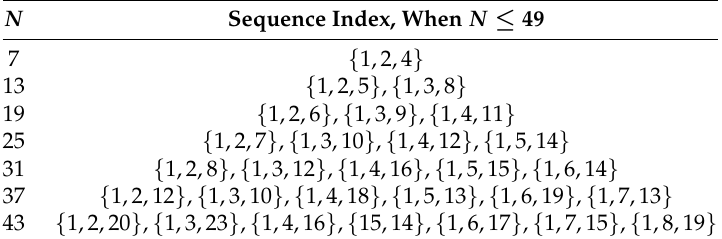
Table 4. Optical orthogonal code (OOC) ( N ,3,1 ) sequence indices for various lengths. N